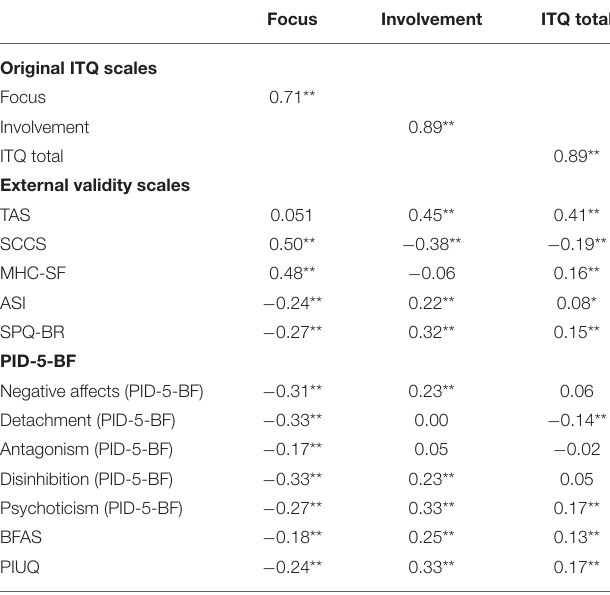
TABLE 5 | Short for ITQ-10 and their correlations with other trait predispositions and behavioral habits. Focus Involvement ITQ